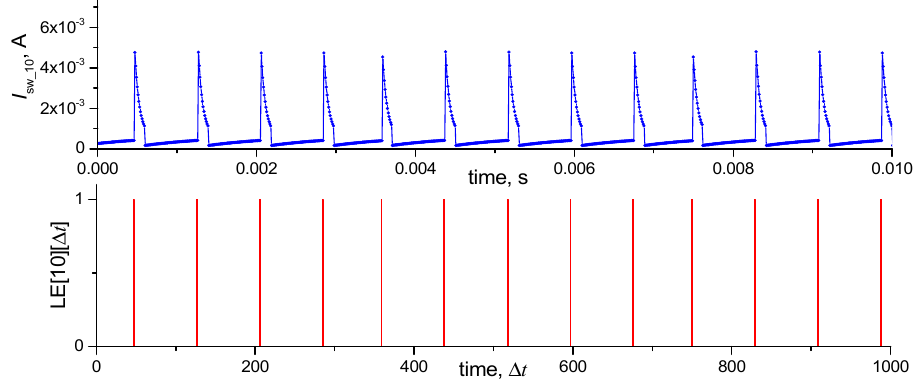
Figure 5. Oscillogram of oscillator current No. 10 and the corresponding array of positions of the leading edges of the current pulse LE [10] [ Δ t]. Δ t—calculation time interval (Appendix A.1).